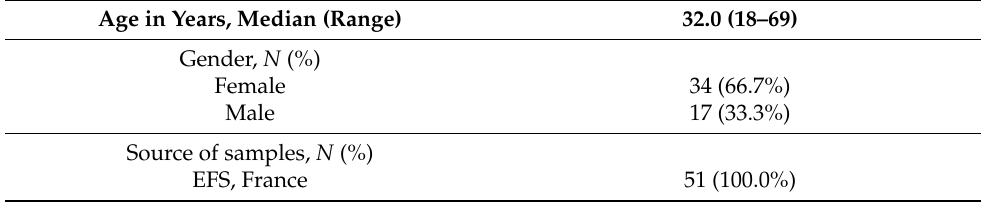
Table 6. Healthy donors’ characteristics ( N = 51).